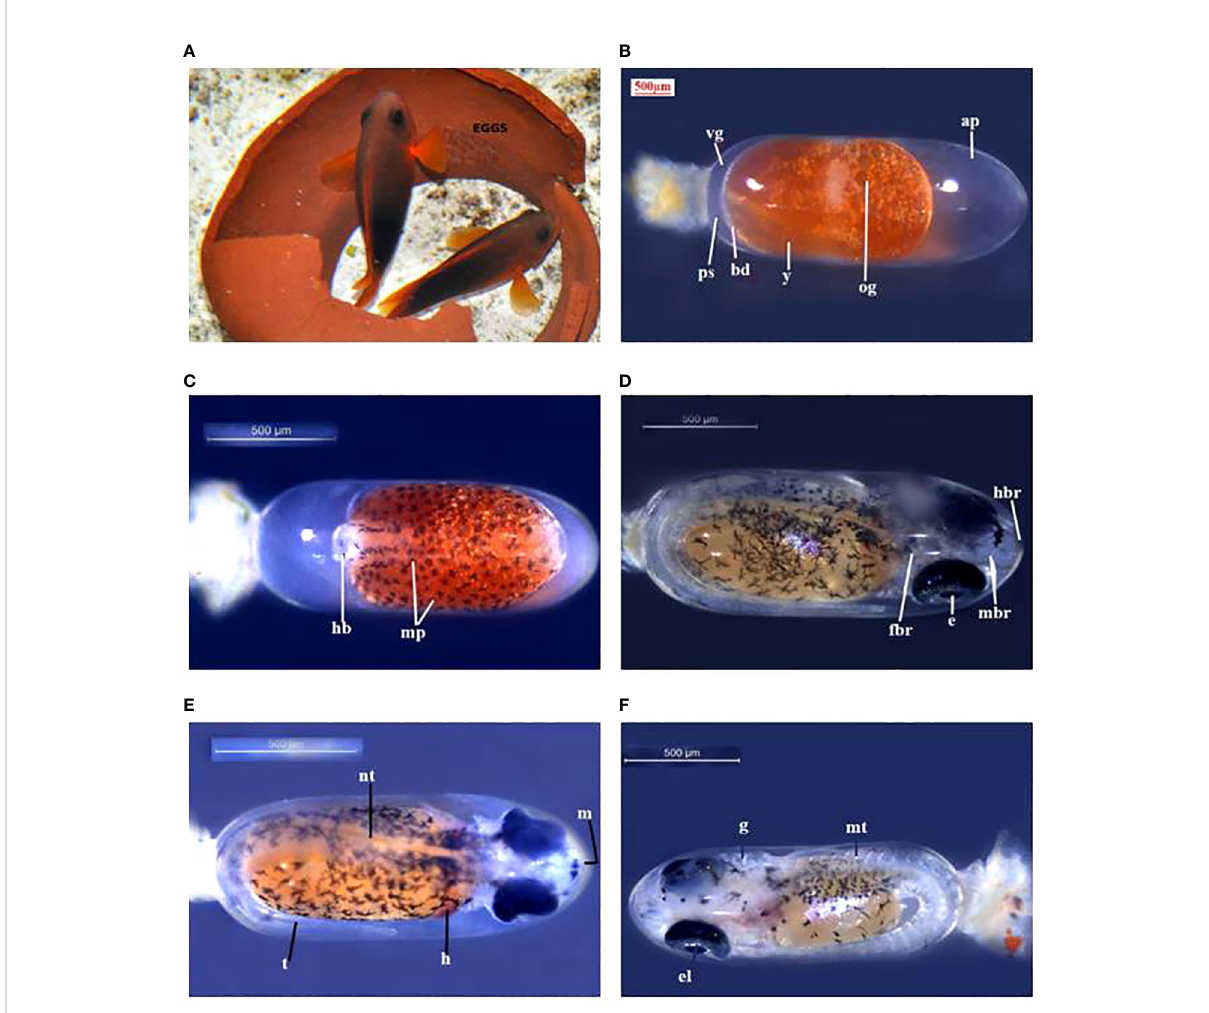
FIGURE 4 A. ephippium (A) broodstock, (B) egg (day 1), (C) egg (day 2), (D) egg (day 3), (E) egg (day 4), (F) egg (day 5). ap, animal pole; bd, blastodisc; e, eye; el, eye lens; fbr, forebrain; g, gills; h, heart; hb, head bud; hbr, hindbrain; m, mouth; mbr, midbrain; mp, melanophore; mt, myotomes; nt, notochord.; og, oil globule; ps, perivitelline space; t, tail; vg, vegetal pole; y,